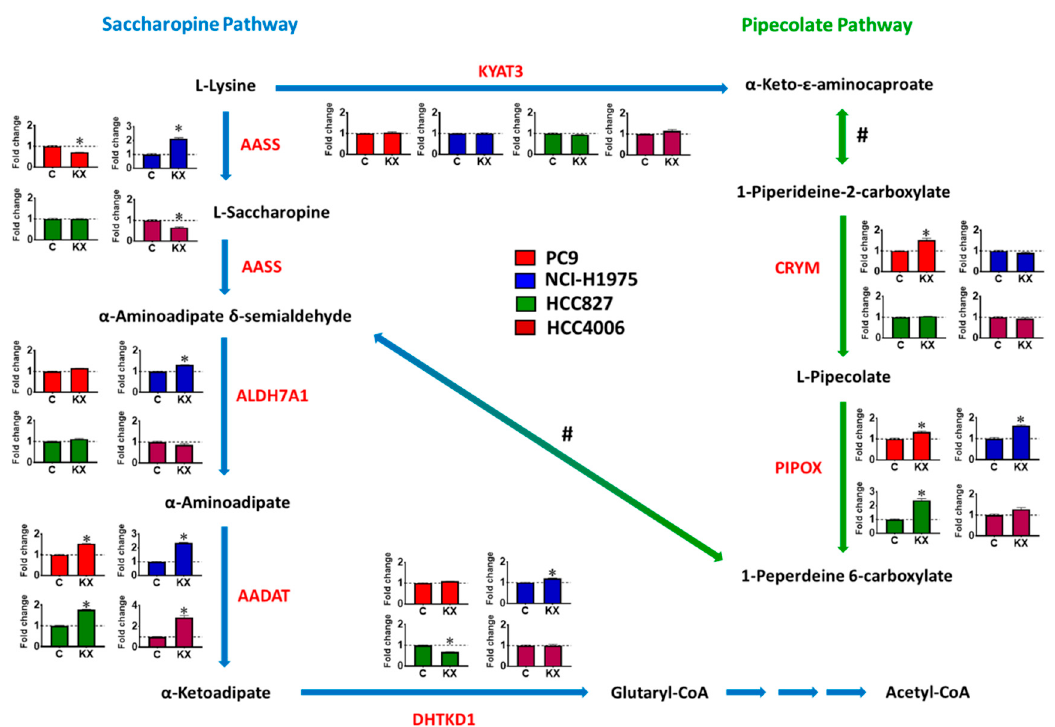
Figure 4. The effects of lysine deprivation on the expression of genes of the lysine catabolism pathway in EGFR -mutant NSCLC cells. The graph illustrates the mechanisms of the saccharopine pathway (blue line) and the pipecolate pathway (green line). Each EGFR -mutant NSCLC cell line (red bar: PC9, blue bar: NCI-H1975, green bar: HCC827, purple bar: HCC4006) was incubated with medium corresponding to either lysine-deprived (0 μ M lysine) or control (220 μ M lysine) conditions for 24 h. The expression of genes involved in lysine catabolism was then analyzed using qPCR. The relative fold change in expression levels for each gene in each lysine-deprived group was normalized according to the corresponding control. The result is representative of three independent experiments. C, normal RPMI; KX, lysine-deprived RPMI; AADAT , kynurenine/ α -aminoadipate aminotransferase; AASS (L-lysine to L-saccharopine), α -aminoadipic semialdehyde synthase; AASS (L-saccharopine to α -aminoadipate δ -semialdehyde), saccharopine dehydrogenase; ALDH7A1 , α -aminoadipic semialdehyde dehydrogenase; CRYM , ketamine reductase; DHTKD1 , 2-oxadipate dehydrogenase; KYAT3 , kynurenine aminotransferase 3; PIPOX , L-pipecolate oxidase; #, spontaneous and nonenzymatic. The data are presented as the mean ± SEM from three-independent experiments. (*, p < 0.05 compared with the normal RPMI group).